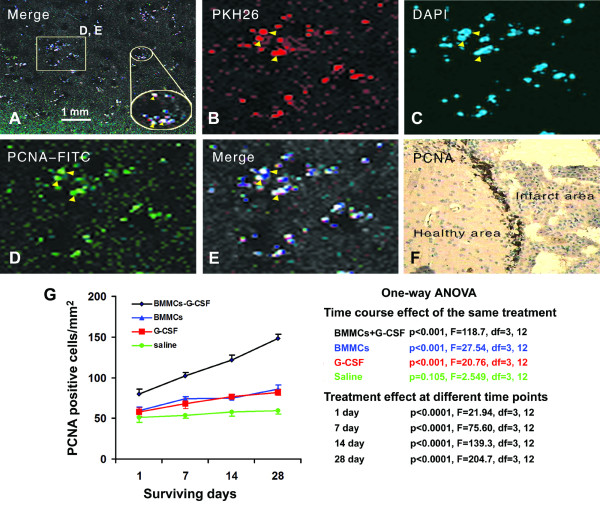
Colocalization of transplanted BMMCs with PCNA and densitometry of PCNA expressing cells at various surviving times. Panels A to E are representative confocal images showing that transplanted BMMC, pre-labeled by PKH26 (red) and DAPI (blue), co-localize with proliferative cell nuclear antigen (PCNA, green). (F) illustrates PCNA immmunoreactive cells visualized with the DAB method around the infarct border of the infarct area. (G) shows semi-quantitative data of PCNA positive cells at different time points in the 4 groups of animals. ANOVA table on the right denotes statistical analysis data on the time course effect (longitudinal factor) in the 4 animal groups as well as treatment effect (transversal factor) at the 4 time points.